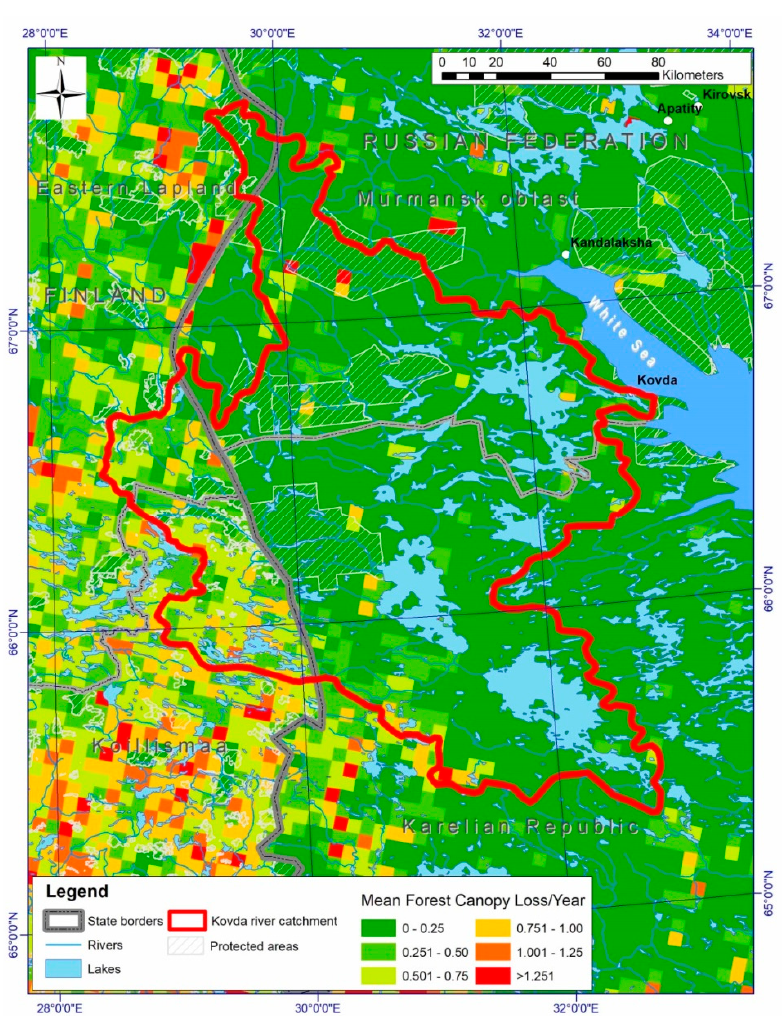
Figure 2. Map showing mean forest canopy loss for the period 2000–2018 (for methods see [60]) using a 25 × 25 km grid. Note that the protected area borders are generalised.